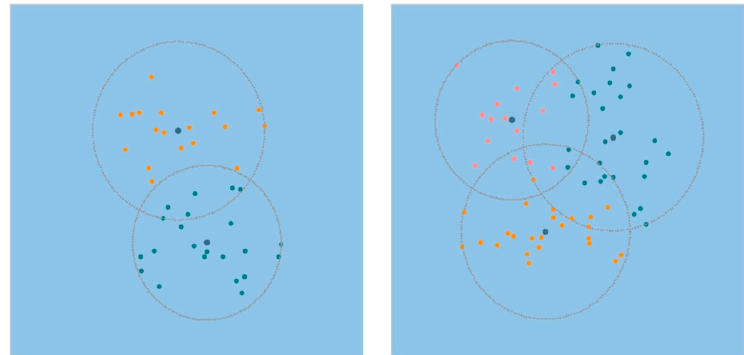
Figure 4. The results of clustering of the persons in distress by k-means*.